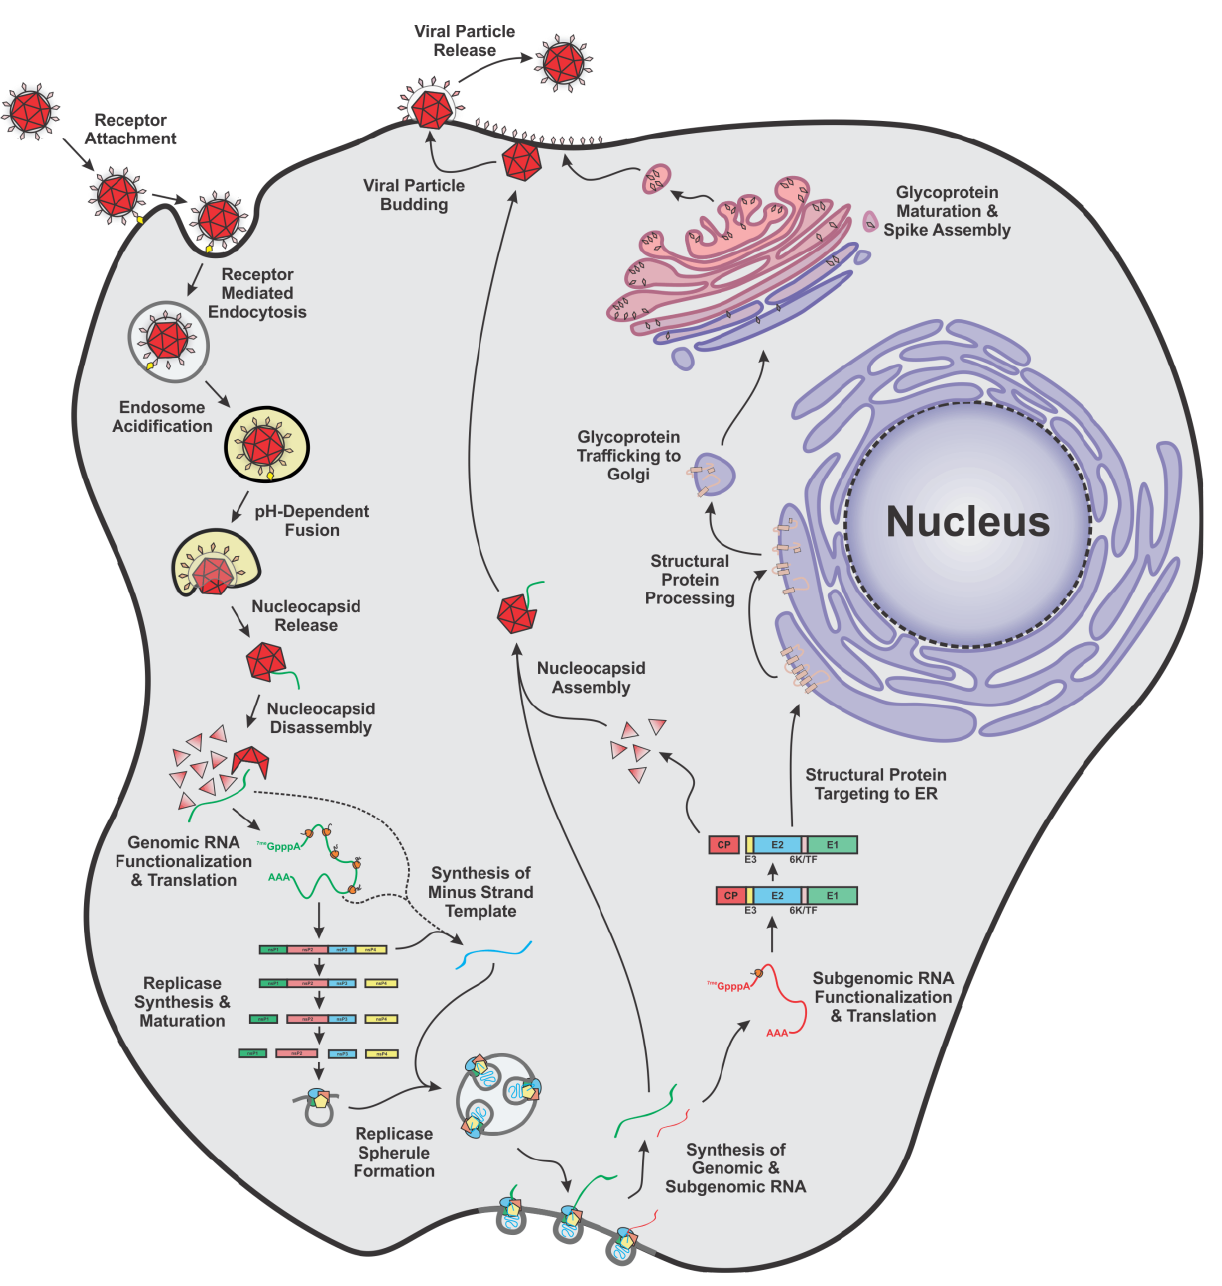
Figure 1 . A Schematic Diagram of the Alphavirus Lifecycle. A simplified schematic diagram of the major lifecycle events as noted in the text.